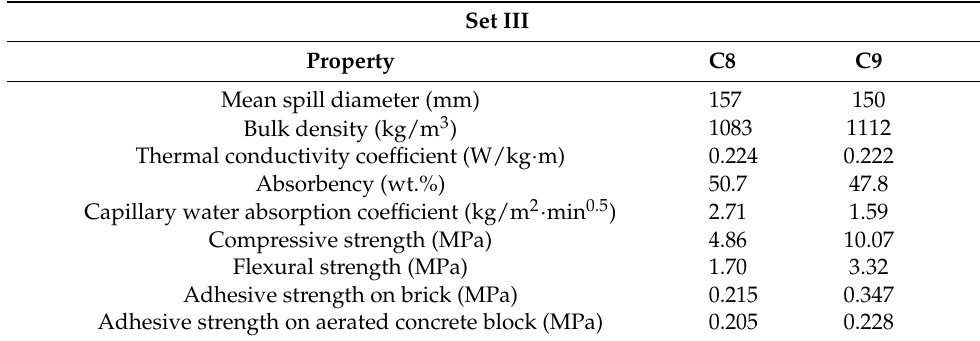
Table 8. Properties of fresh fiber-cement mixtures, hardened mortars, and adhesive strength on two substrates of brick (B) and aerated concrete block